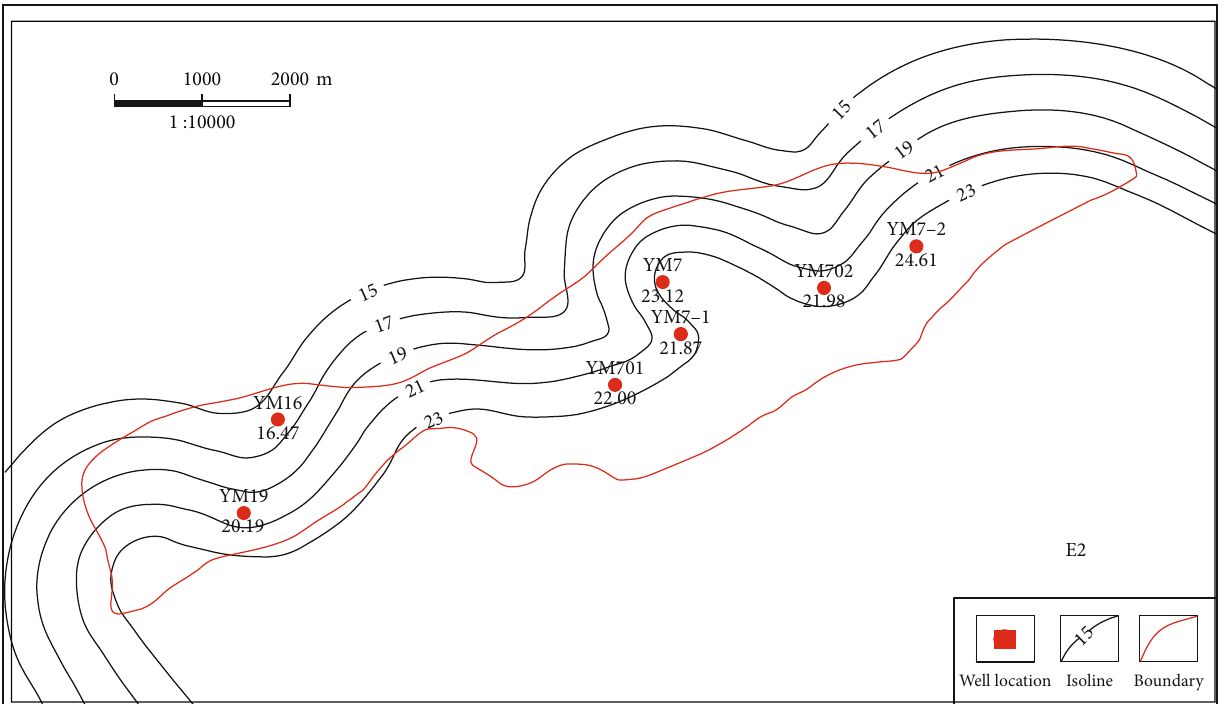
Figure 13: Porosity plane contour map of layer E2 in Yingmai 7 block.